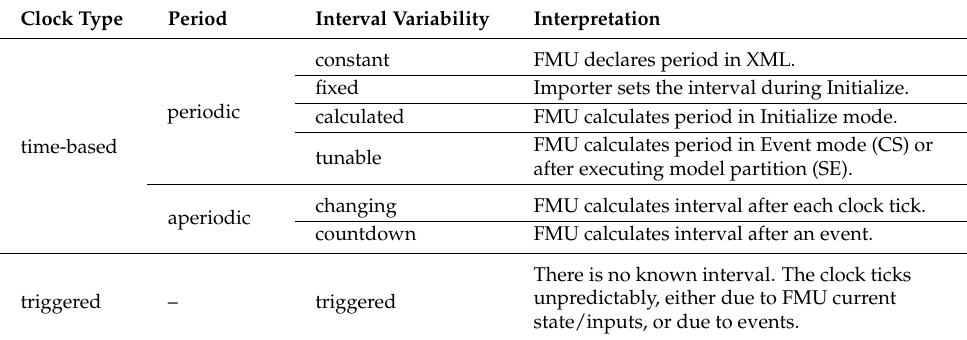
Table 1. Overview of clock types and their attributes. Clock Type Period Interval Variability